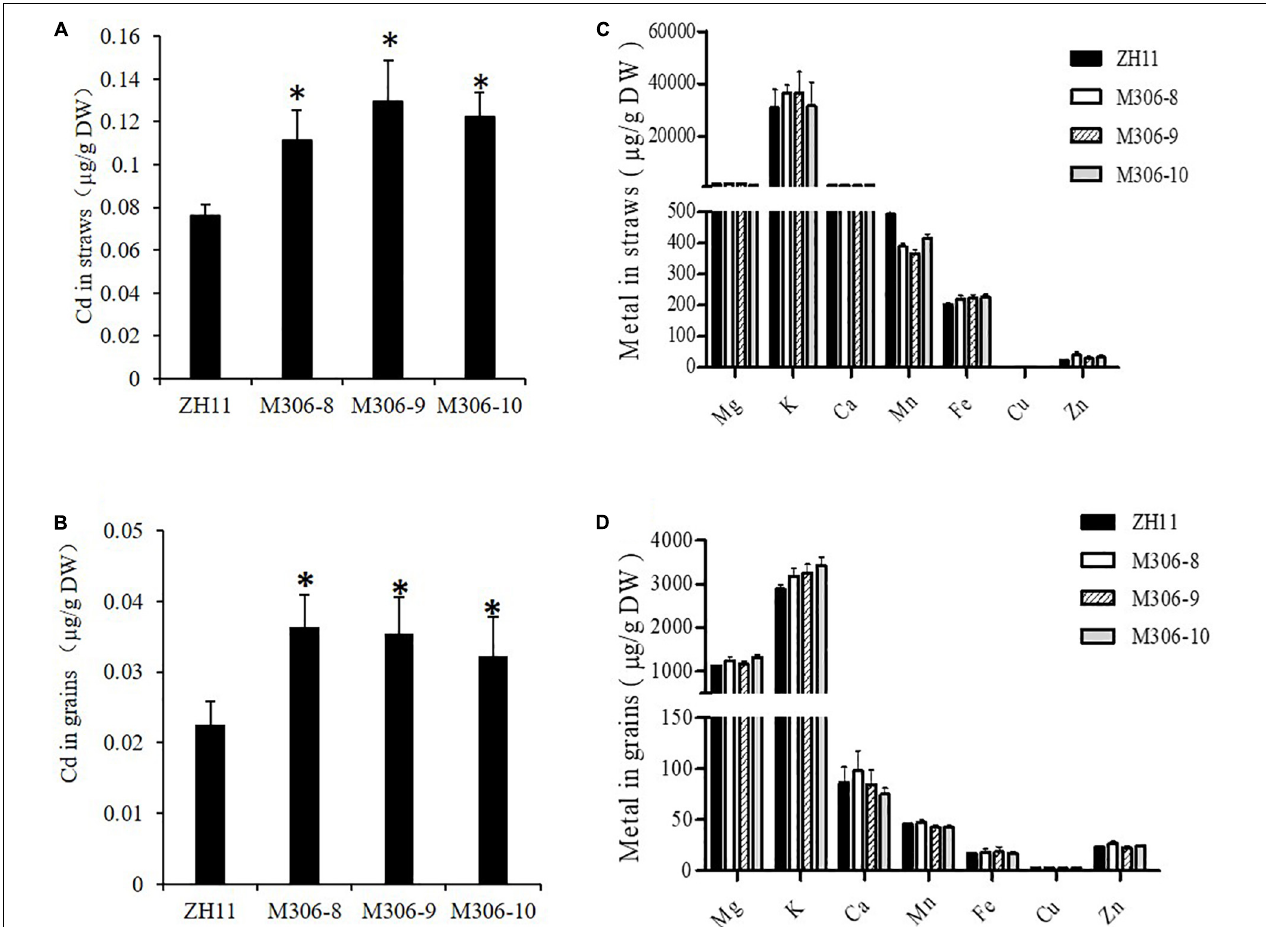
FIGURE 6 | Overexpression of CAL2 increased Cd accumulation in rice. Transgene-negative control ZH11 and 35S:CAL2-mRFP transgenic plants were grown in a heavy metal contaminated paddy field until ripening. Heterologous overexpression of CAL2 increased cadmium (Cd) accumulation in rice straws (A) and grains (B) . (C,D) Essential mineral nutrients accumulation in (C) rice straws and (D) grains. Data are means ± SDs of three independent biological replicates. Significant differences from ZH11 were determined by Student’s t -test ( ∗ P < 0.05).